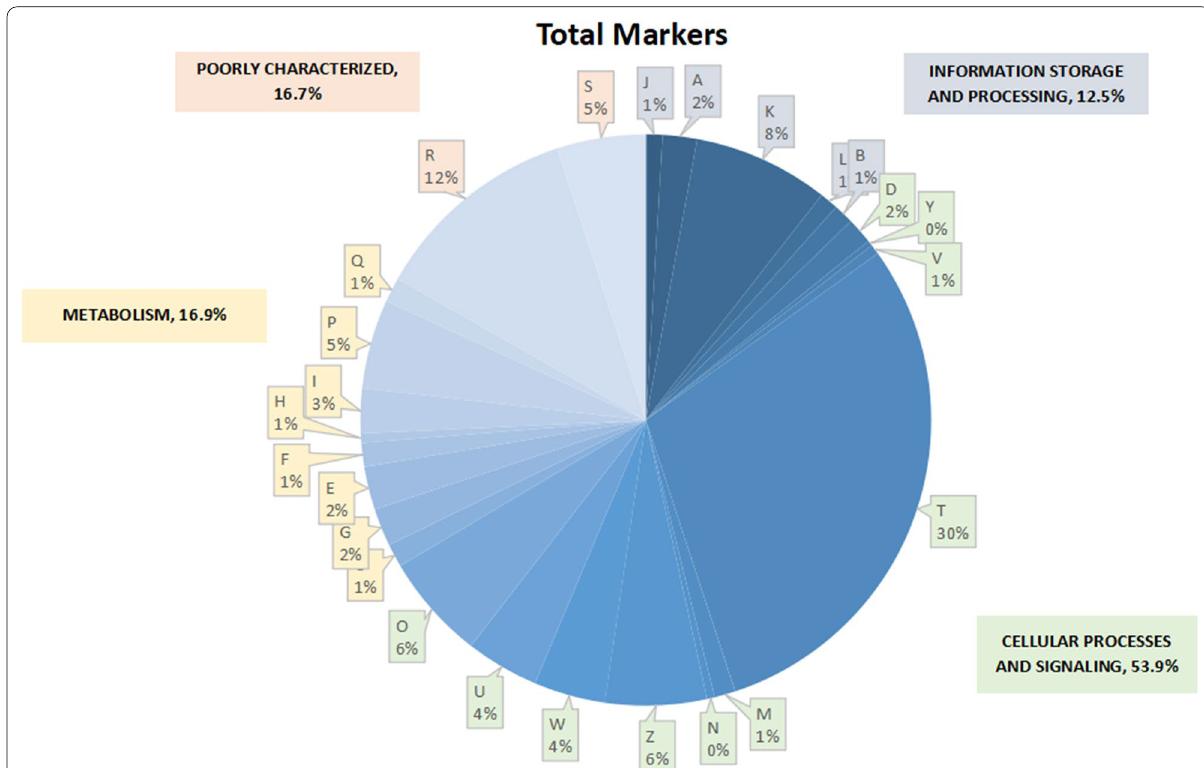
Fig. 5 KOG Functional Classification Analysis of total markers among the subjects. Information Storage and processing: J-Translation, ribosomal structure and biogenesis, A-RNA processing and modification, K-Transcription, L-Replication, recombination and repair, B-Chromatin structure and dynamics. Cellular processing and signaling: D-Cell cycle control, cell division, and chromosome partitioning, Y-Nuclear structure, V-Defense mechanisms, T-Signal transduction mechanisms, M-Cell wall/membrane/envelope biogenesis, N-Cell motility, Z-Cytoskeleton, W-Extracellular structures, U-Intracellular trafficking, secretion, and vesicular transport, O-Posttranslational modification, protein turnover, chaperones. Metabolism: C-Energy production and conversion, G-Carbohydrate transport and metabolism, E-Amino acid transport and metabolism, F-Nucleotide transport and metabolism, H-Coenzyme transport and metabolism, I-Lipid transport and metabolism, P-Inorganic ion transport and metabolism, Q-Secondary metabolites biosynthesis, transport and catabolism. Poorly characterized: R-General function prediction only, S-Function